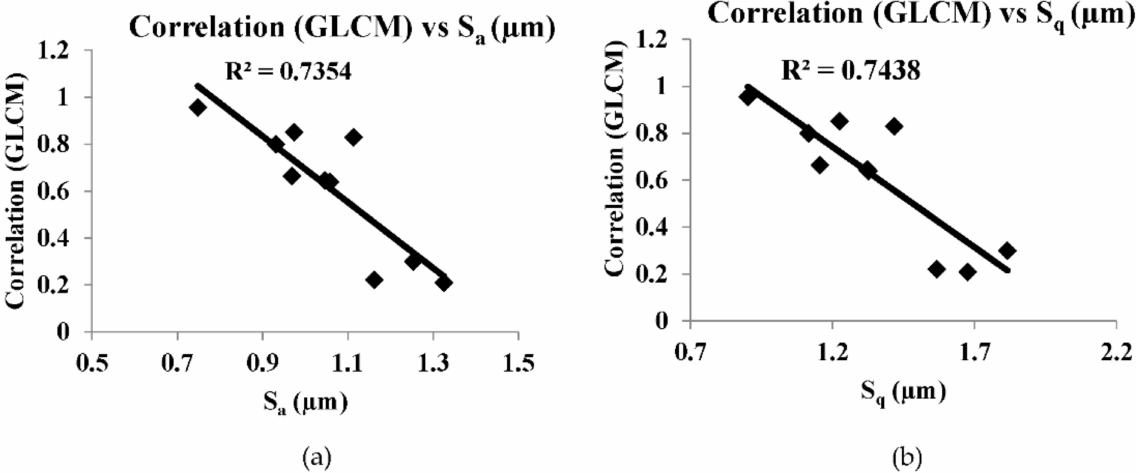
Figure 8. ( a , b ) are correlation plots between the characteristic features and roughness parameter with camera setting of f -number of 8, shutter speed 1/200 s and illumination angle of 30 ◦ .